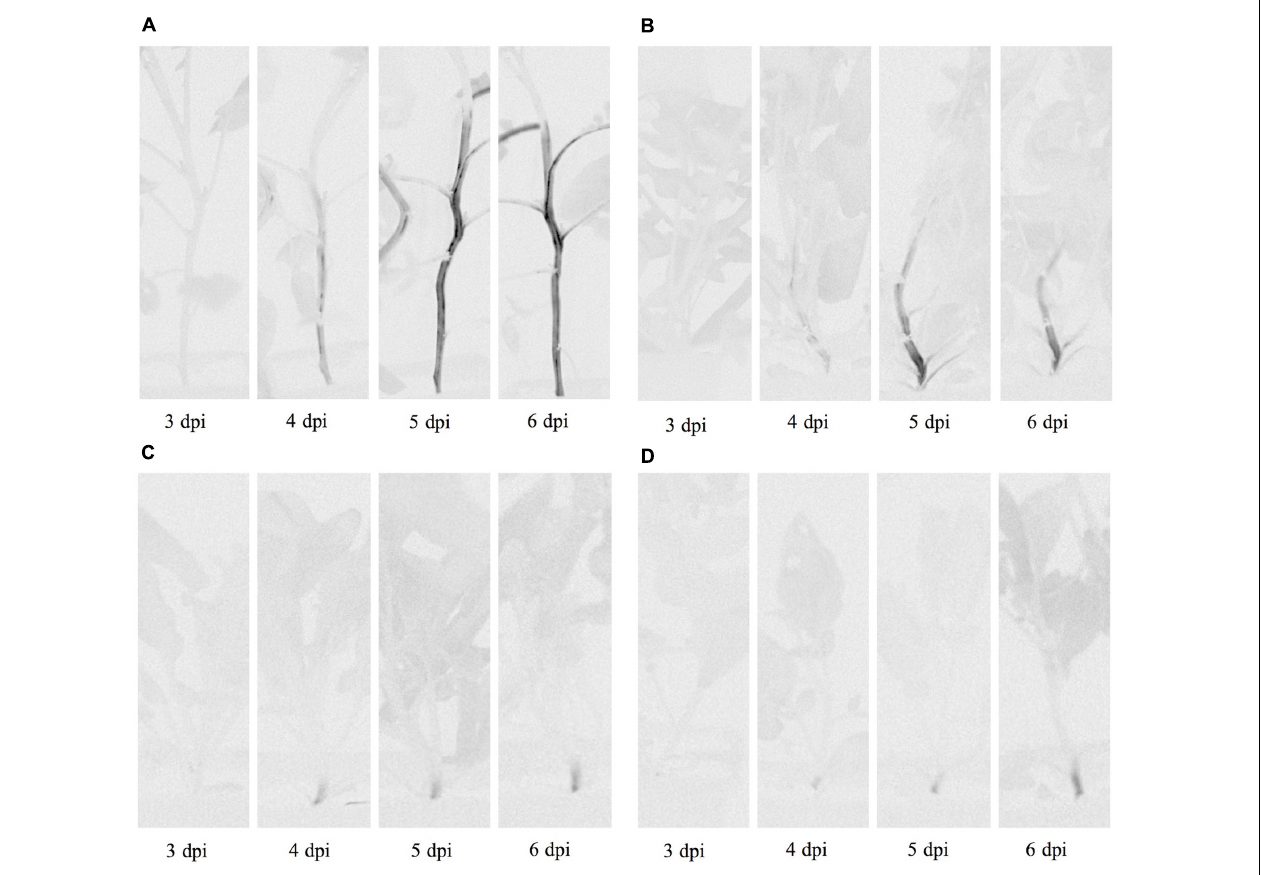
FIGURE 1 | Bioluminescence imaging of Ralstonia solanacearum strain UY031 Pps-lux colonization pattern in different potato genotypes. (A) Susceptible potato cultivar Solanum tuberosum cv. Chieftain. (B) Susceptible potato clone 13001.79. (C) Tolerant potato clone 13001.107. (D) Tolerant potato clone 11201.27. Images were acquired 3, 4, 5, and 6 days post inoculation (dpi) using an in vivo imaging system. Light gray indicates background luminescence due to chlorophyll and black regions are tissue areas colonized by light-emitting